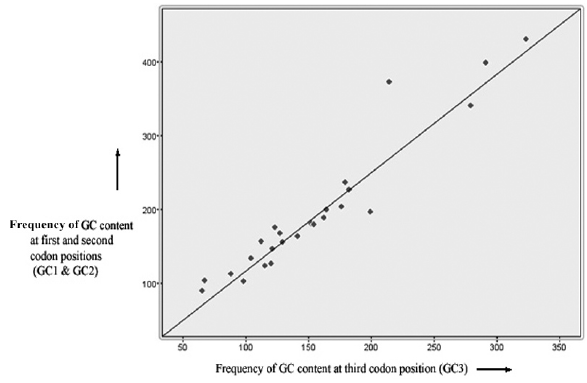
Fig. 1. Correlation between GC content at first and second codon positions (GC1 & GC2) with that at third codon position (GC3). GC12 is the average of GC content at first and second codon